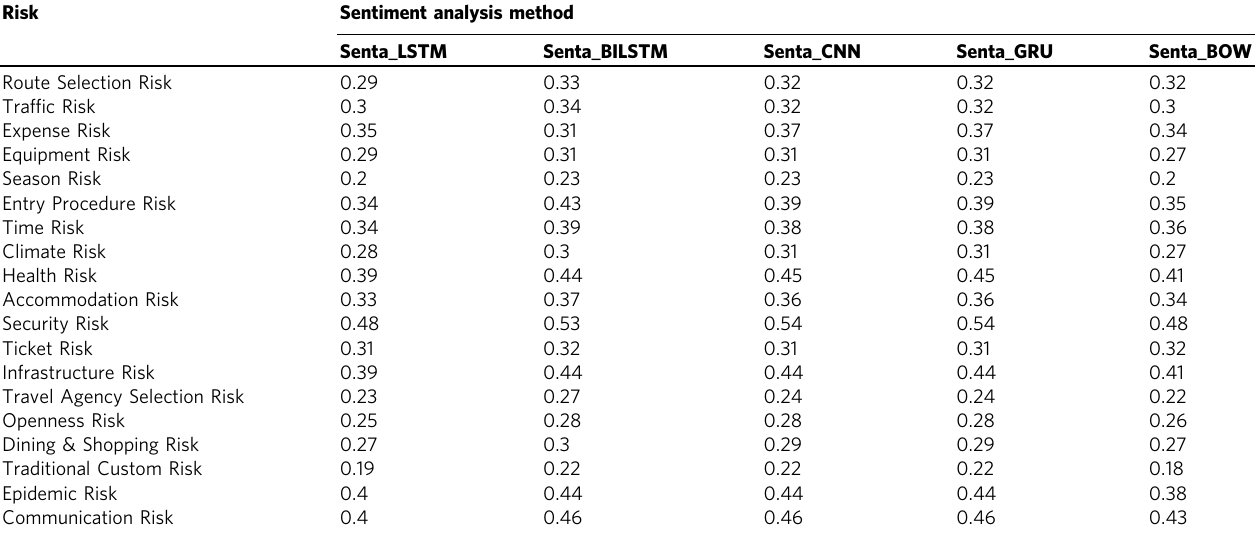
Table 3 Negative sentiment probability of post-travel perceived risks.